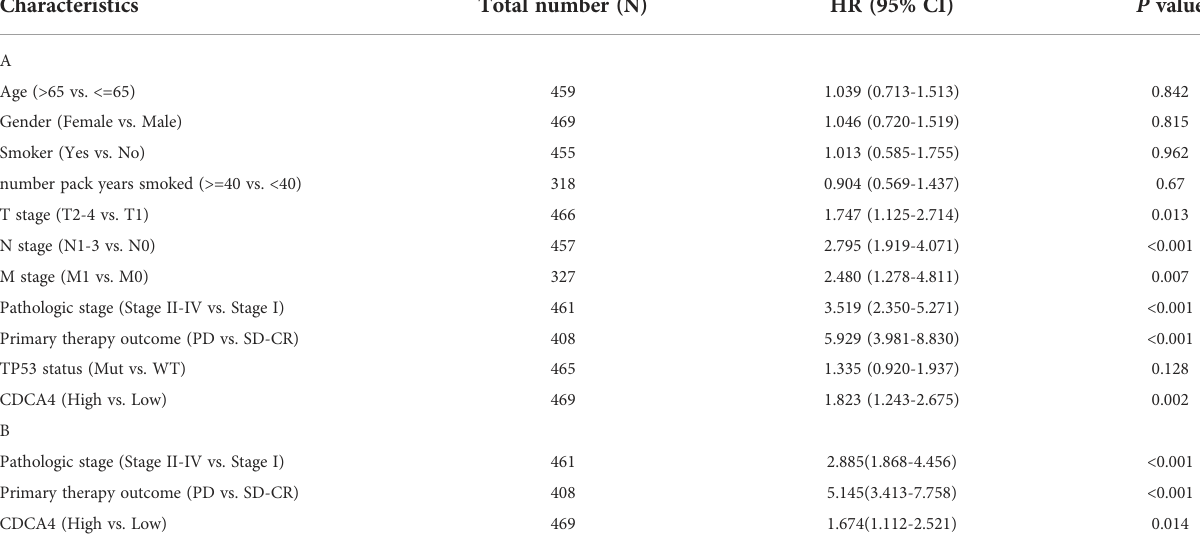
TABLE 3 Univariate and multivariate analysis of the relationship between disease speci fi c survival and clinicopathologic characteristics in patients with TCGA.